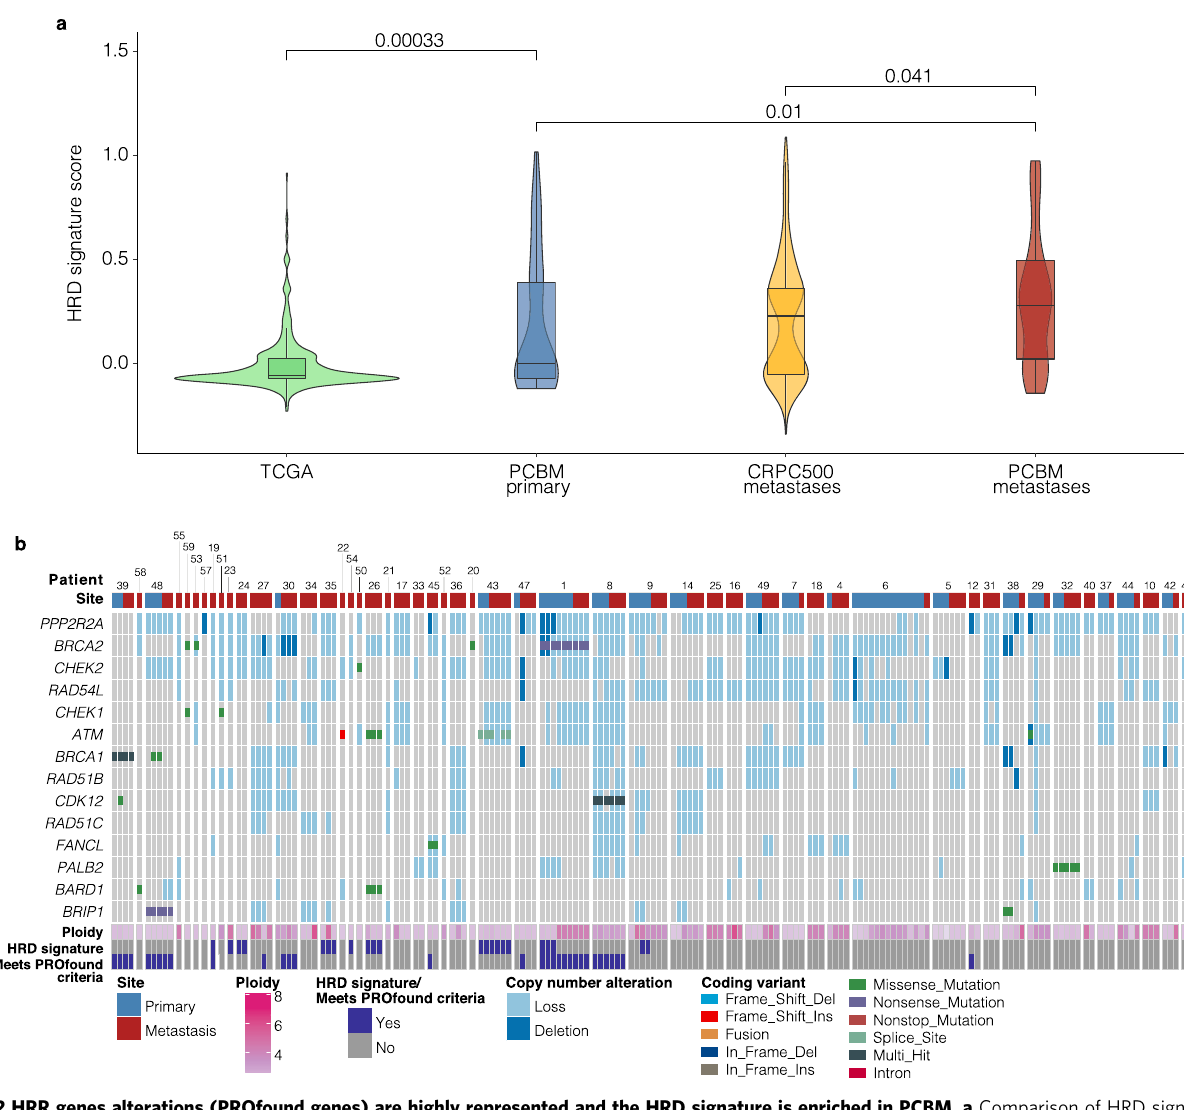
Fig. 2 HRR genes alterations (PROfound genes) are highly represented and the HRD signature is enriched in PCBM. a Comparison of HRD signature scores, estimated by SigMA for TCGA ( n = 495), PCBM primary ( n = 63), CRPC500 non-brain metastatic ( n = 411), and PCBM metastatic ( n = 105) samples (Wilcoxon test, two sided). Horizontal lines in boxplots show median, hinges show interquartile range, whiskers show 1.5 x interquartile range, points beyond 1.5 x IQR past hinge are shown. b Summary of mutations and copy number alterations affecting HR genes included in the PROfound clinical trial. Alterations (coding and copy number) are colored according to the legend. Ploidy annotation from FACETS and samples passing the HRD Signature ‘ strict ’ cutoff from SigMA are indicated. Source data are provided as a Source Data fi